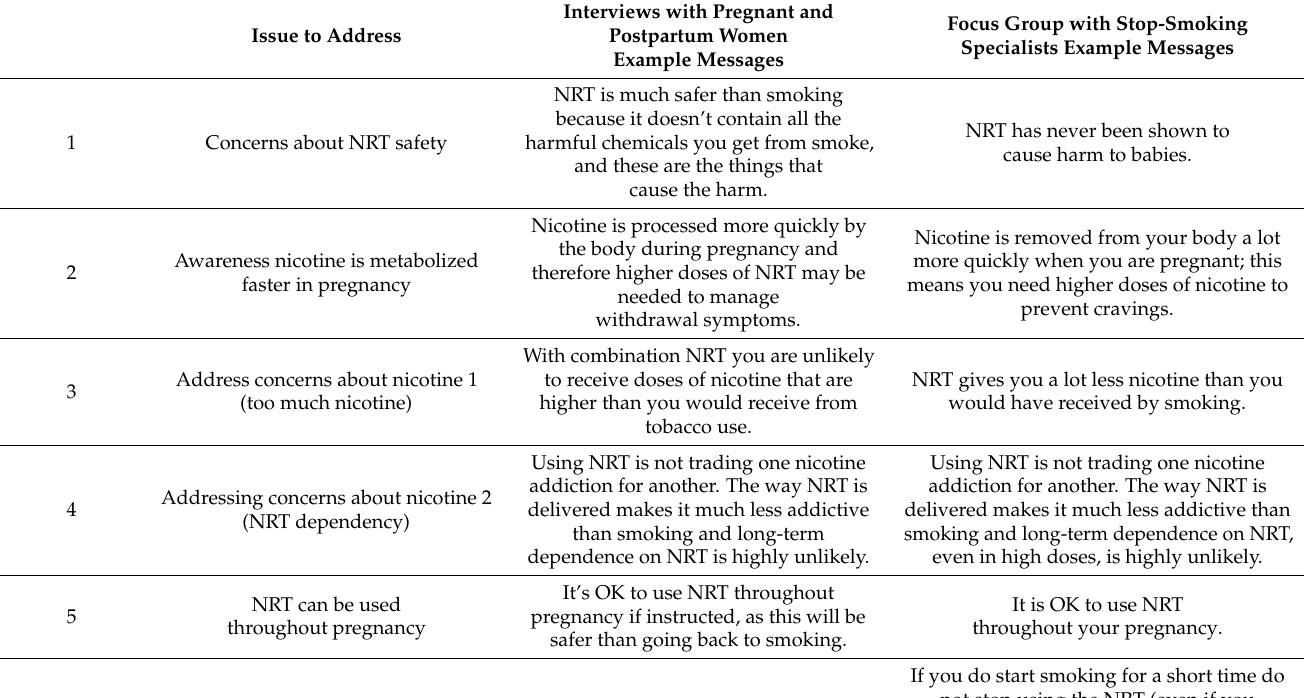
Table 1. Issues to address and associated intervention messages discussed in the interviews with women and the focus group with stop-smoking